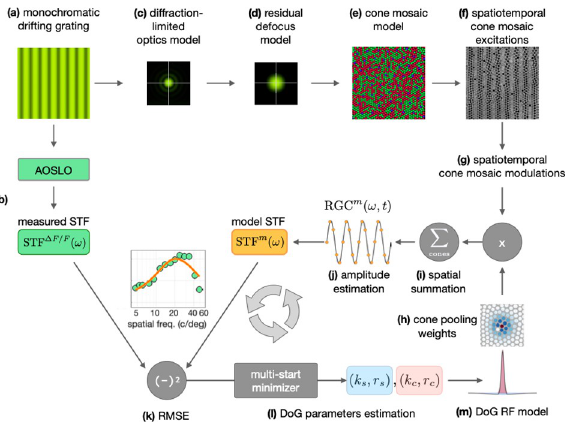
Fig 6. Schematic overview of the ISETBio modeling approach. To interpret the AOSLO-based STF measurements (Fig 5) in terms of the spatial pooling of cone signals to the measured RGCs we model the spatial, spectral and temporal aspects of the stimulus, the optics, the cone mosaic and the cone pooling within the center and surrounds mechanisms of an RGC using the ISETBio toolbox. (a) A frame of the drifting monochromatic grating stimulus which is projected through the AOSLO system to stimulate and measure the GCaMP fluorescence–based spatial transfer function (STF) of RGCs, STF Δ F/F ( ω ) (b). The drifting grating is modeled as a temporal sequence of spatial spectral radiance scenes. These scenes model the AOSLO display including a diffraction-limited optical system with a 6.7 mm pupil (c) combined with residual defocus in the eye’s wave aberrations (d). The resulting sequence of retinal irradiance maps are spectrally integrated and spatially averaged within the apertures of cones in a model of the animal’s cone mosaic (e) , resulting in a spatiotemporal sequence of cone excitations (f). Cone excitations are transformed to cone modulations by first subtracting and subsequently dividing the mean cone excitation level (g). Modulation signals from different cones are scaled by the spatial weights with which the RF center and the RF surround mechanism pool cone signals (h). The weighted cone signals are subsequently summed (i) to compute the temporal response of the model RGC. A sinusoid is fitted to the RGC temporal response (j) and the amplitude of the sinusoid is taken as the STF of the model RGC at the stimulus spatial frequency, STF m ( ω ). The RMSE between STF m ( ω ) and STF Δ F/F ( ω ) (k) is minimized using a multi-start solver which optimizes the center and surround peak sensitivity and radius